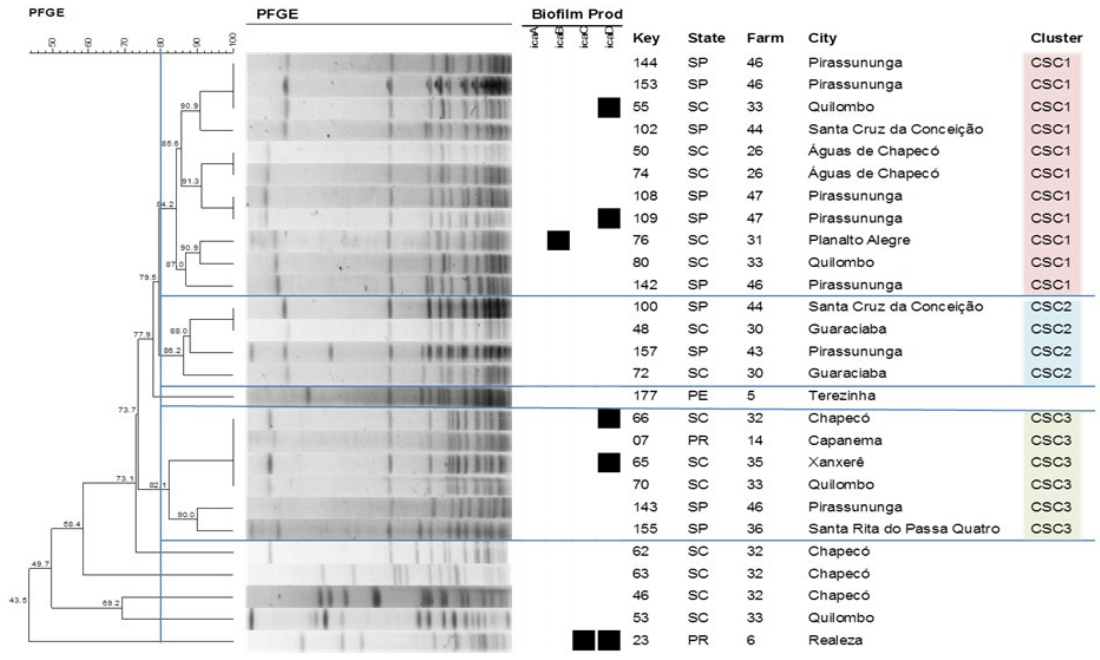
Figure 3. Dendrogram generated from the PFGE pattern of Staphylococcus chromogenes isolates (Dice similarity coefficient; clustering method: UPGMA). All Staphylococcus chromogenes isolates were negative for the bhp gene.